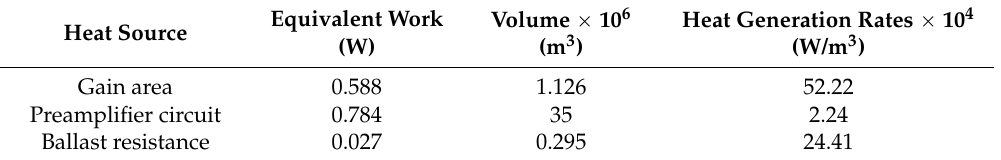
Table 2. The heat source in RLG assembly model.